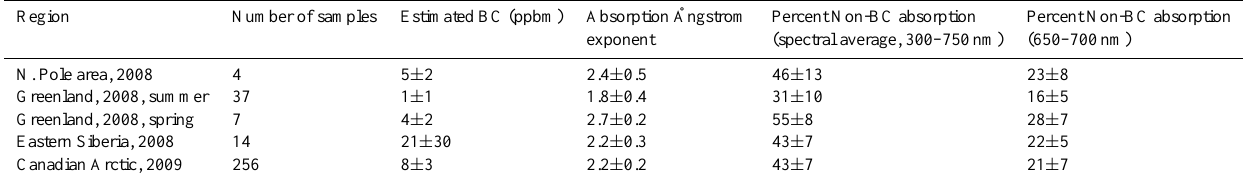
Table 1. Shown are the median and standard deviation of estimated BC ( C EST and the fraction of non-BC light absorption, spectrally integrated from 300–750nm and at 650–700nm. Data are for surface samples only (N. Pole, Russia, Canada and Greenland spring) or of new snow (Greenland summer).